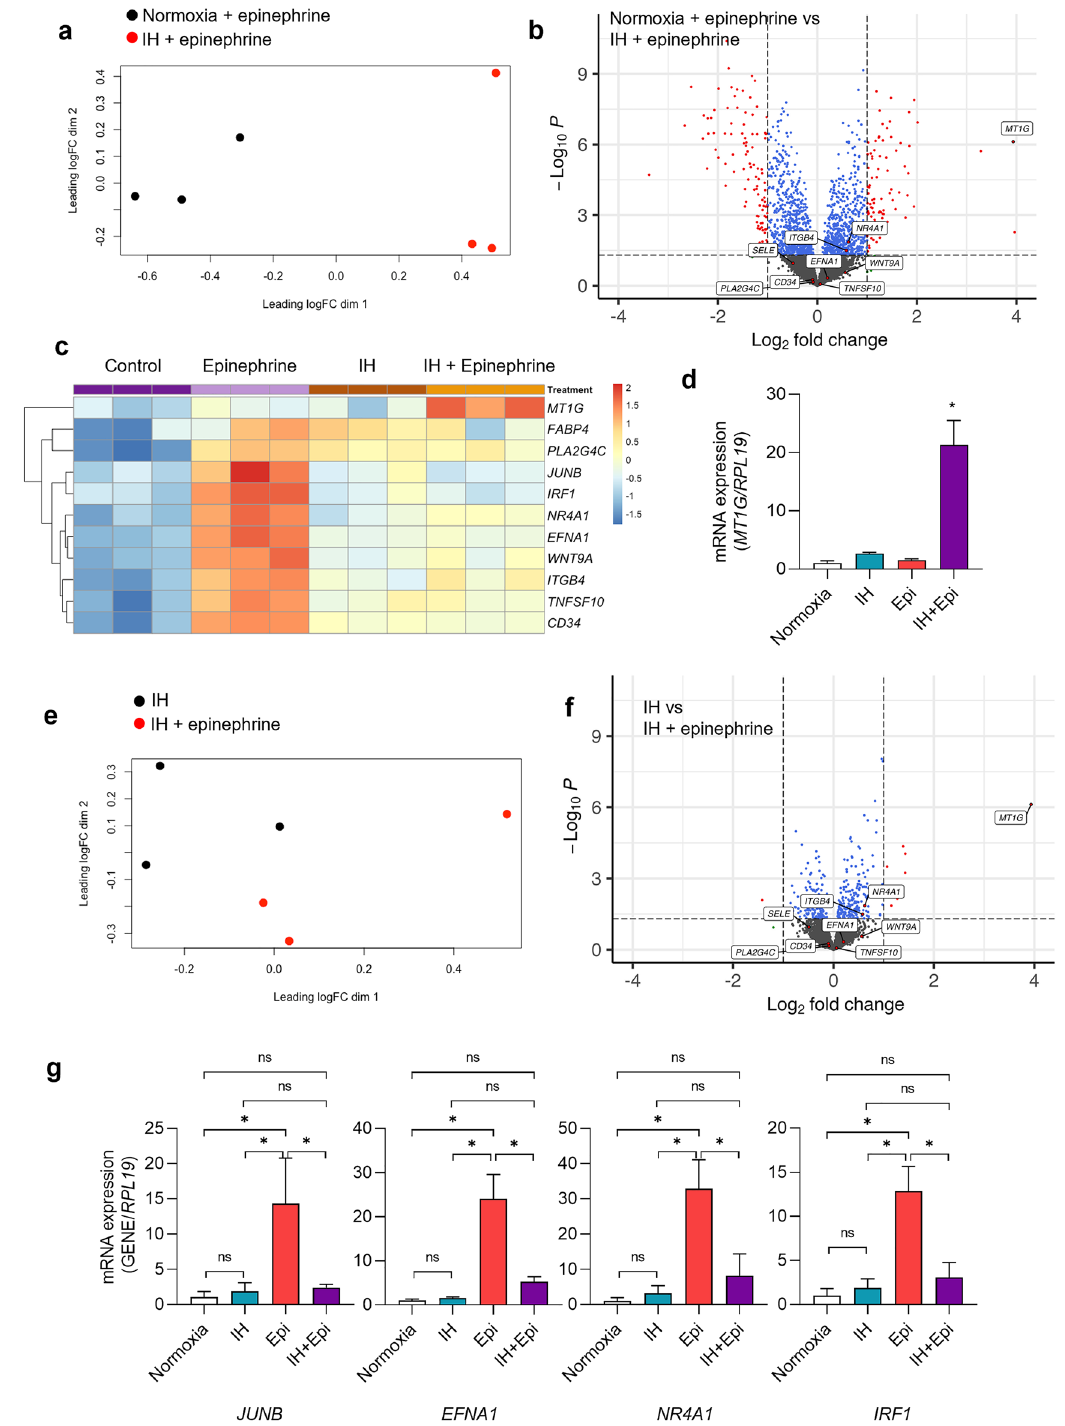
Figure 4. Combining IH with epinephrine significantly alters epinephrine-induced changes in gene expression. HAECs were exposed to 60 cycles of IH (5%-20% O 2 ) in the presence of 10 µM epinephrine and vehicle control. We then isolated RNA from 3 biologic replicates and performed RNA-sequencing. ( a ) Multidimensional scaling plot and ( b ) Volcano plots of DEGs in HAECs treated with normoxia + epinephrine and IH + epinephrine. ( c ) Heat map displaying the expression level of top epinephrine-upregulated genes in HAECs treated with epinephrine or vehicle control under normoxic and IH conditions. “Pretty heatmaps R package pheatmap package” from Z-score normalized expression values. https:// cran.r- proje ct. org/ web/ packa ges/ pheat map/ pheat map. pdf ( d ) Using qPCR, we measured mRNA expression of MT1G measured by qPCR in HAECs treated and untreated with 10 µm epinephrine under IH and normoxia (mean ± SD, n = 6, biologic replicates). * p < 0.05. ( e ) Multidimensional scaling plot of DEGs in HAECs treated with IH in the presence or absence of epinephrine (10 µM). ( f ) Volcano plot of DEGs in HAECs treated with IH in the presence or absence of epinephrine. Metallothionein-1G ( MT1G) is highly differentially upregulated under IH supplemented with 10 µM epinephrine. ( g ) We also measured mRNA expression of epinephrine-upregulated genes, JUNB, EFNA1 , IRF1 , and NR4A1 in HAECs treated with epinephrine or vehicle control under normoxic and IH conditions (mean ± SD, n = 6, biologic replicates). * p <